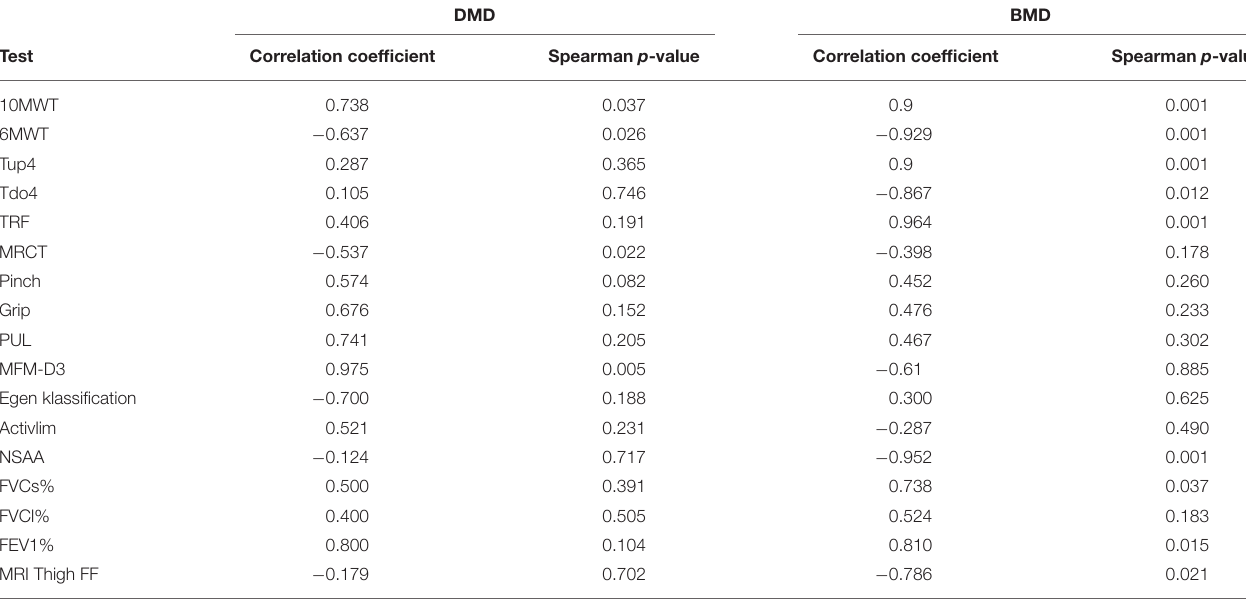
TABLE 2 | Correlation between PDGF-AA serum levels and different muscle function tests, spirometry values, and muscle MRI. DMD BMD Test Correlation coefficient Spearman p -value Correlation coefficient Spearman p -value 10MWT